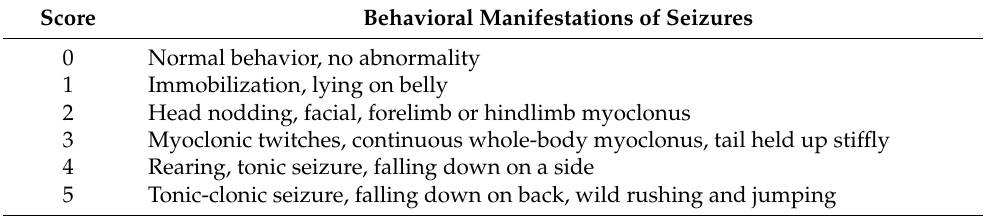
Table 1. Modified Racine scale for visual assessment of the severity of PTZ-induced seizures in rats